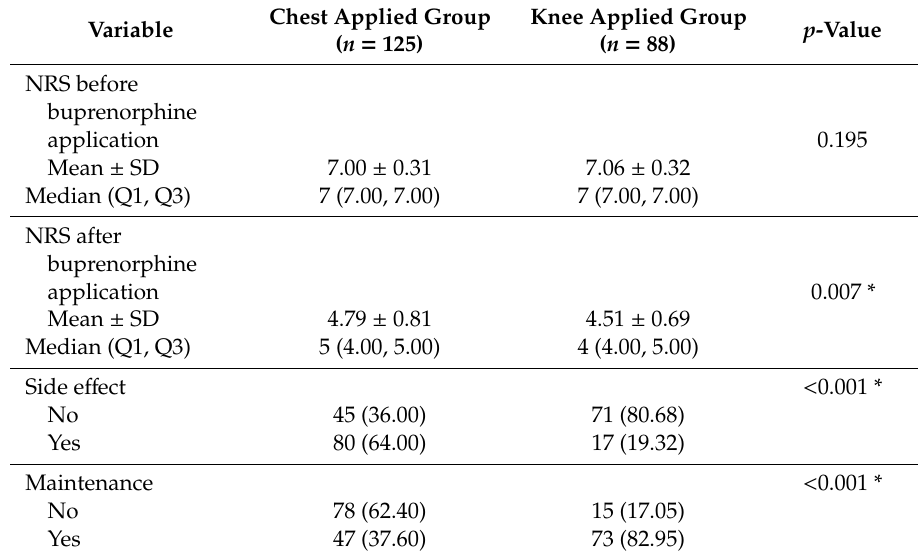
Table 2. Comparison of the Numeric Rating Scale (NRS), adverse e ff ects, and compliance between the chest applied group and knee applied group. (Intention to treat